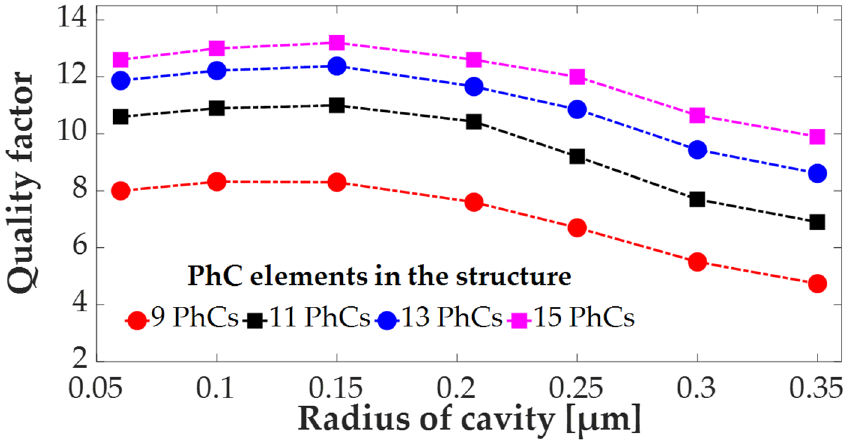
Figure 8. The quality factor of PhC structure for variation in the number of PhC-elements and PhC cavity-radius for the data signal.